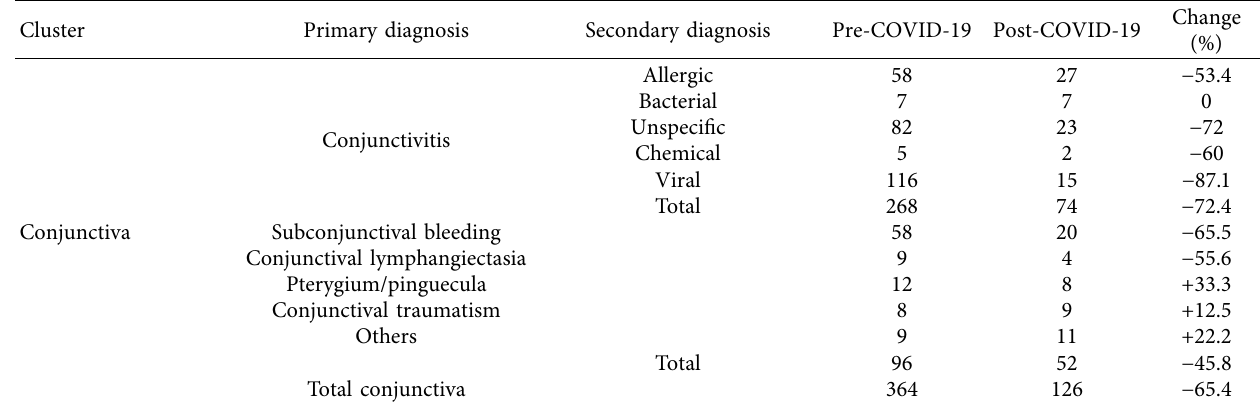
Figure 1: Cluster distribution of patients attended at the emergency department during the pre-COVID-19 and post-COVID-19 period. Table 2: Diagnosis distribution of the most prevalent